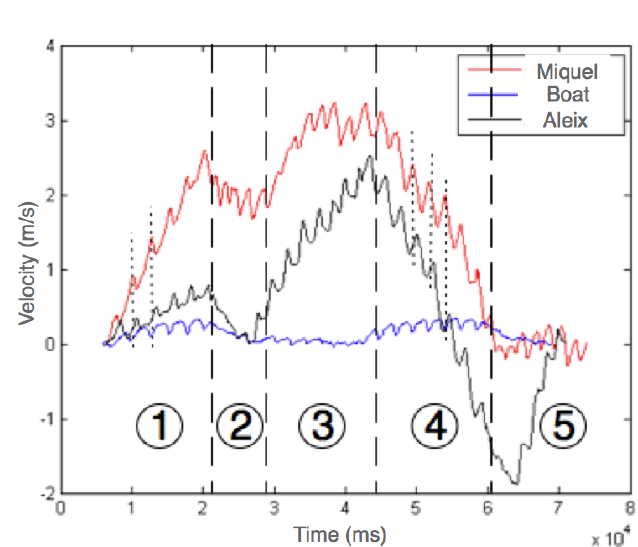
Figure 13. Velocities of the oars and the